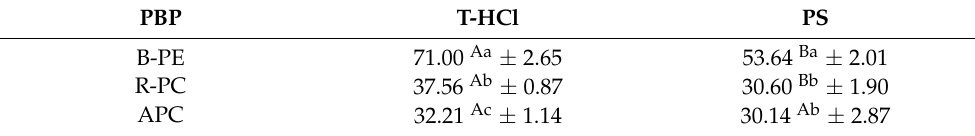
Table 3. Phycobiliprotein concentration of aqueous extracts from P. cruentum (mg · g − 1 PS). PBP T-HCl PS B-PE 71.00 Aa ± 2.65